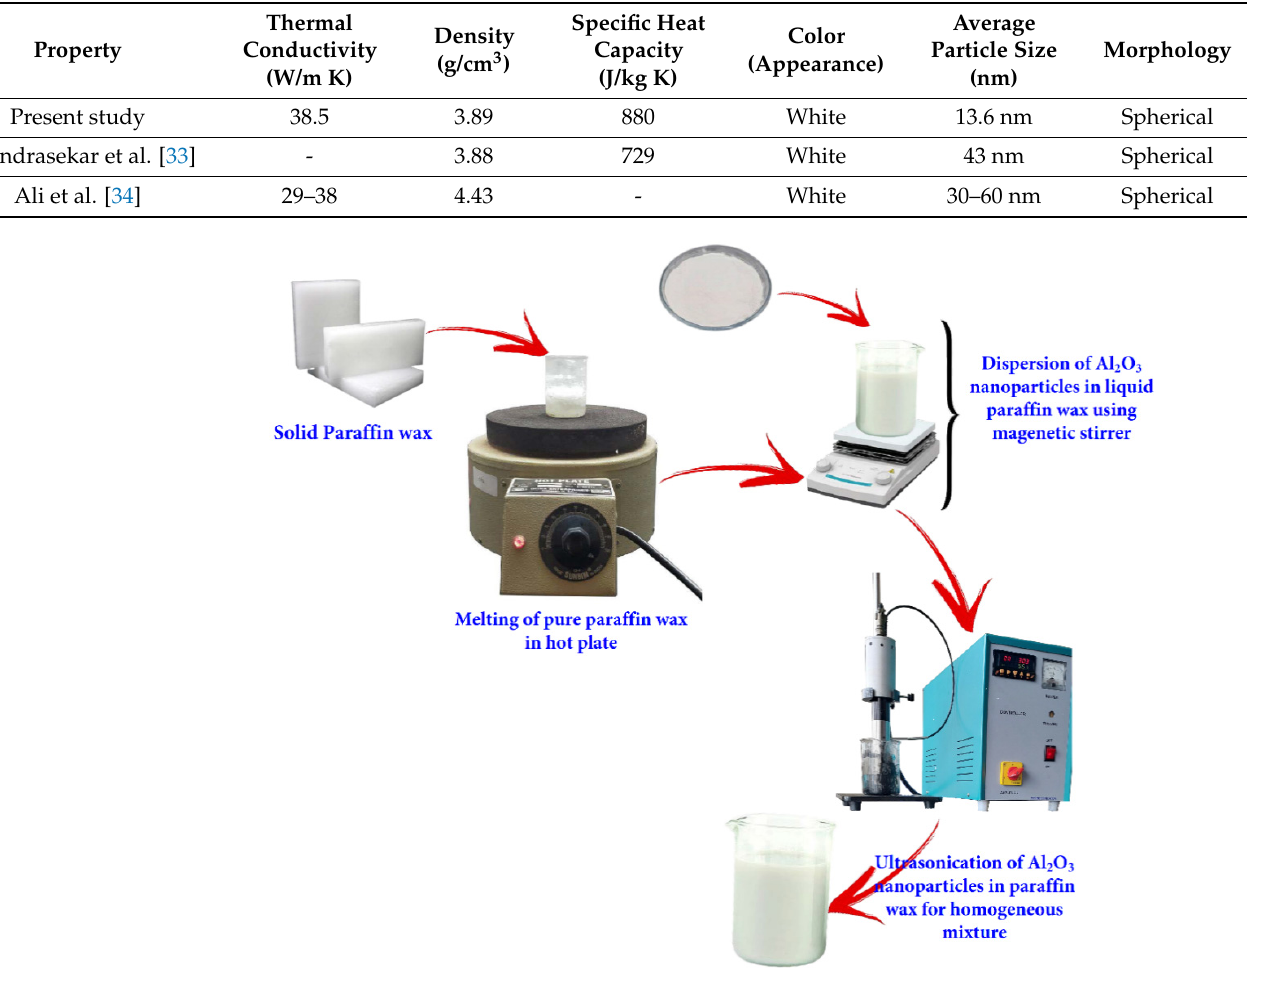
Table 2. Specifications of Al 2 O 3 nanoparticles.